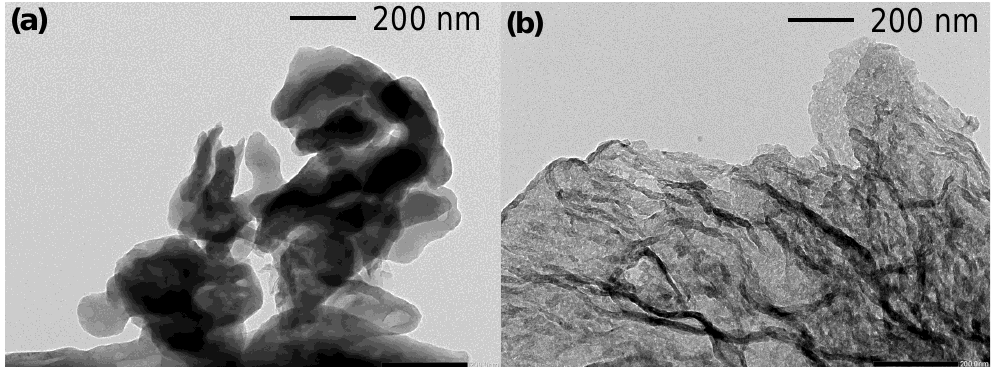
Figure 1. Transmission electron microscopy images of bulk ( a ) and exfoliated ( b ) graphitic carbon nitride (g-C 3 N 4 ).